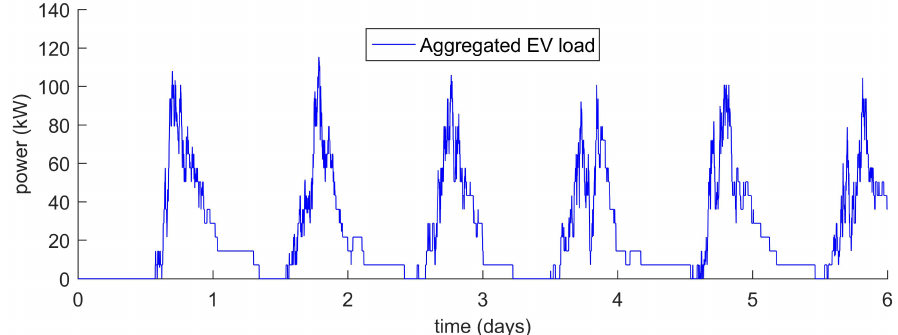
Figure 3. Excerpt from the aggregated 50 EVs; charging powers that were each generated from the empirical models.